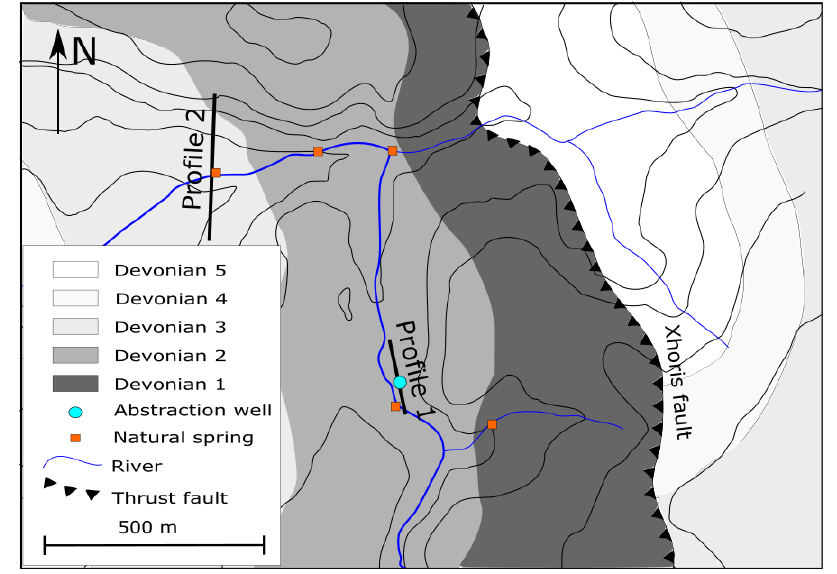
Figure 4. Localisation of Profile 1 and Profile 2 in the first studied site.